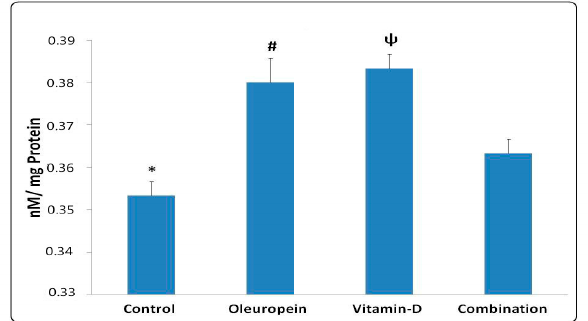
Figure 5. Malondialdehyde analysis results. * Oleuropein and vitamin D treatment has significantly increased the MDA as compared to the control group ( p >